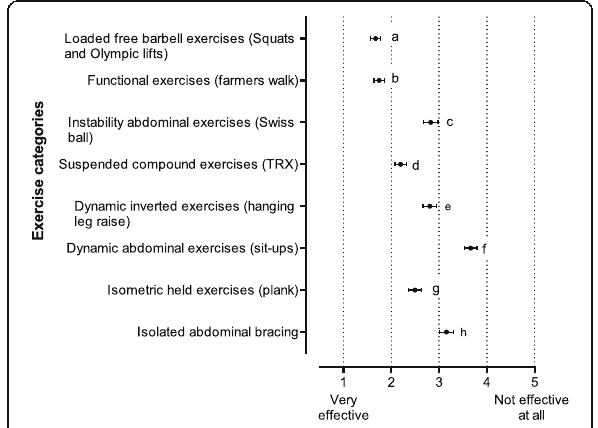
Fig. 2 Responses to a series of questions on the effectiveness of selected categories of exercise in developing core stability for dynamic athletic performance. Data are reported as mean level of effectiveness with 95% CI. 1 = very effective, 5 = not effective at all. Significant differences p < 0.001: a vs c, d, e, f, g and h; b vs c, d, e, f, g and h; c vs d and f; d vs e, f and h; e vs f; f vs g and h; g vs h. CI: confidence interval